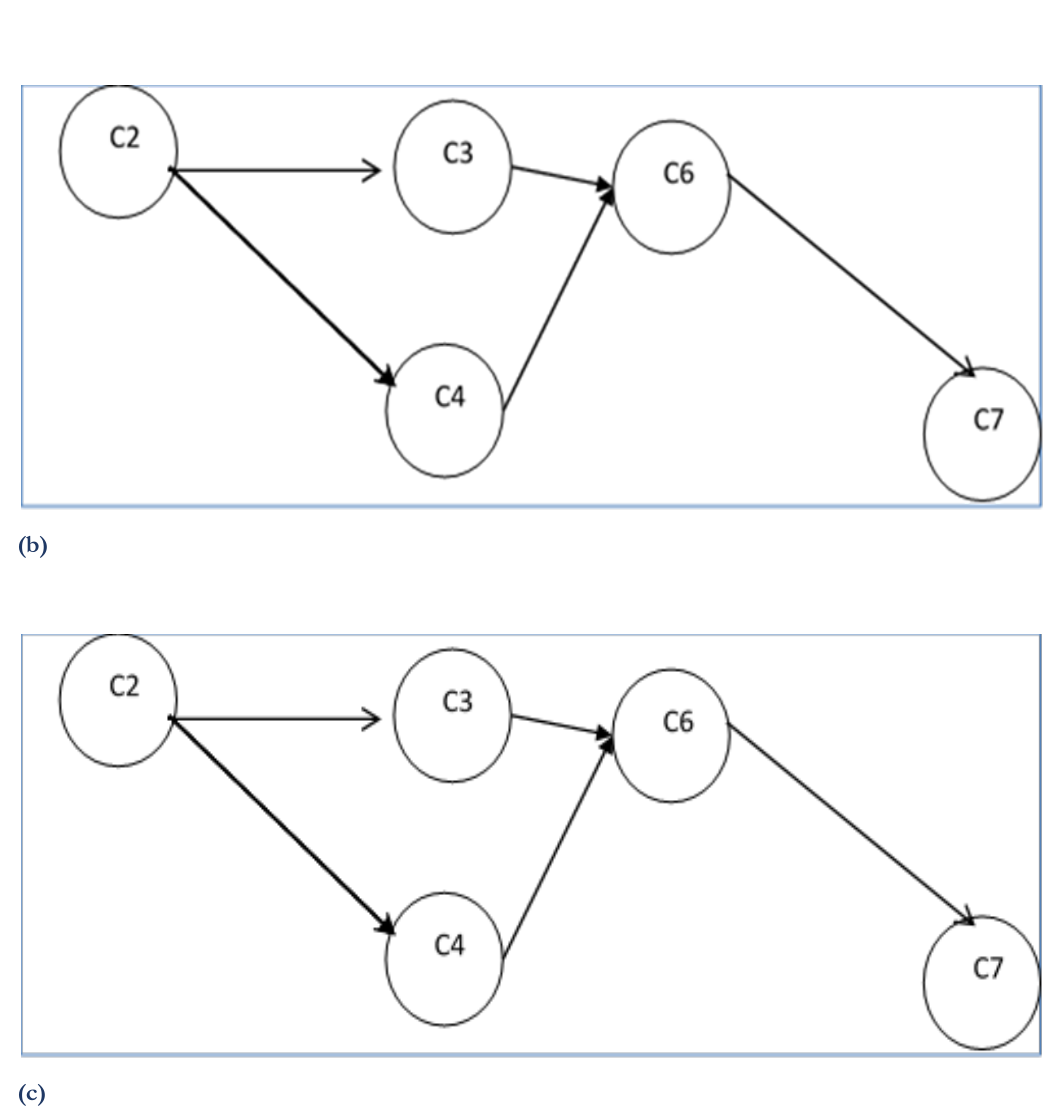
Fig 3. Plithogenic sub cognitive